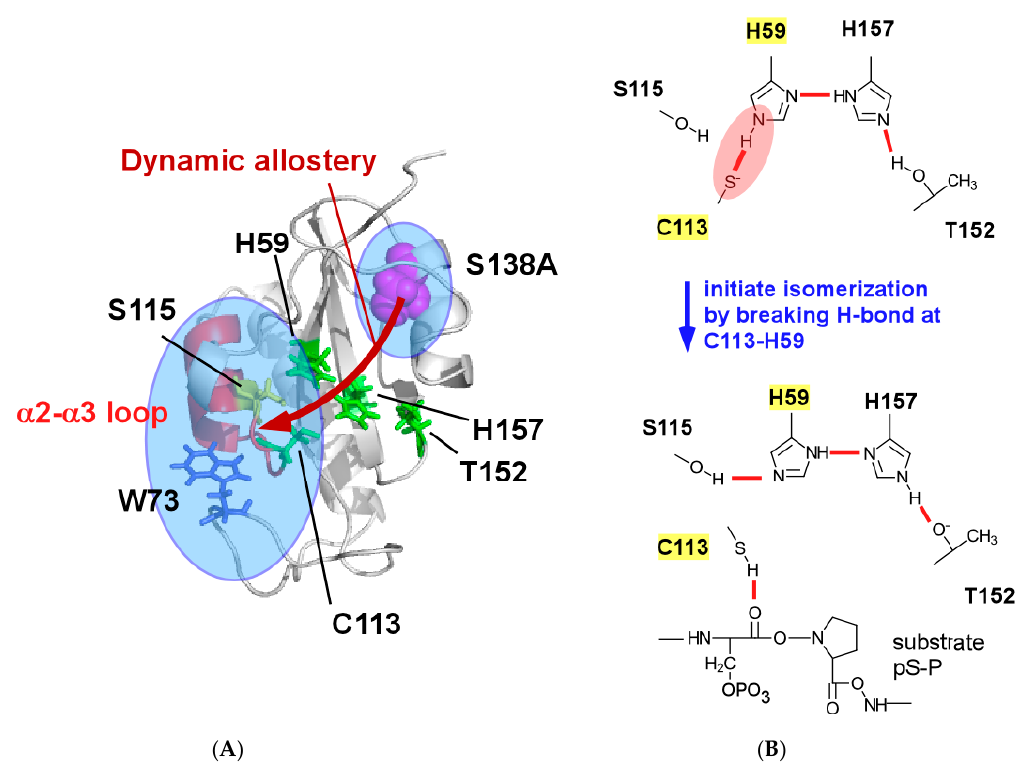
Figure 9. Dynamic allostery caused by the S138A mutation in the PPIase domain retards the isomerization process. ( A ) The S138A mutation rearranges residue-residue contacts among residues at the interdomain interface, marked with small blue circles. The change in residue contacts near the mutation site cause the dynamic allostery to rigidify the α 2- α 3 loop colored in red; ( B ) The reduced dynamics for the α 2- α 3 loop strengthens the hydrogen bond formed by the S γ thiolate of C113 to N ε 2 in the imidazole ring of H59 (top). The isomerization is supposed to rearrange the hydrogen bonds among residues in the hydrogen-bonding network upon binding to substrate, which may be initiated by the breaking of the hydrogen bond between C113 and H59 due to protonation of the thiolate in C113 (bottom) [29]. The strengthened hydrogen bond between C113 and H59 in the mutant when compared with that in the wild-type retards this initiation process because of the inefficient rupture of the C113–H59 hydrogen bond.